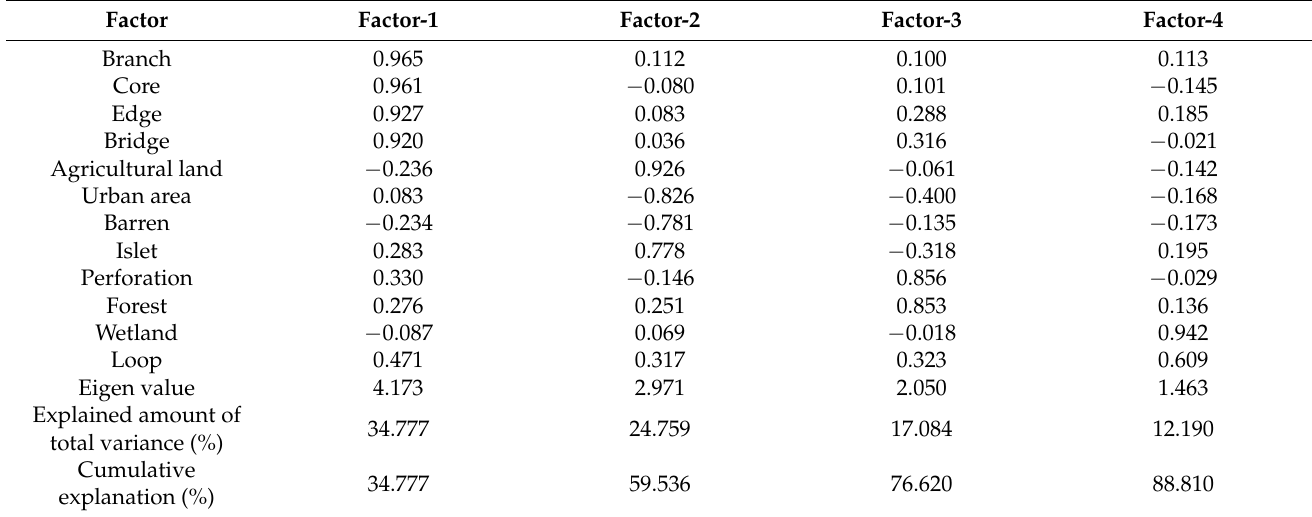
Table 4. Results of factor